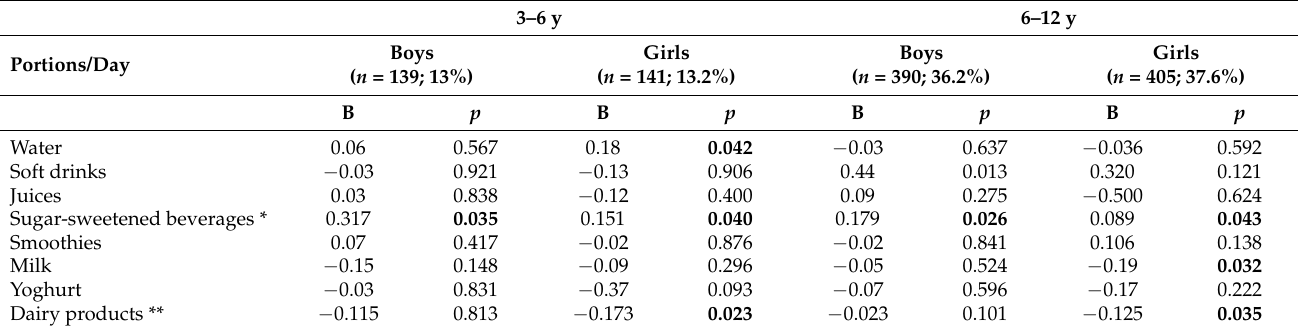
Table 2. Association between beverage consumption and BMI z-score ( n =